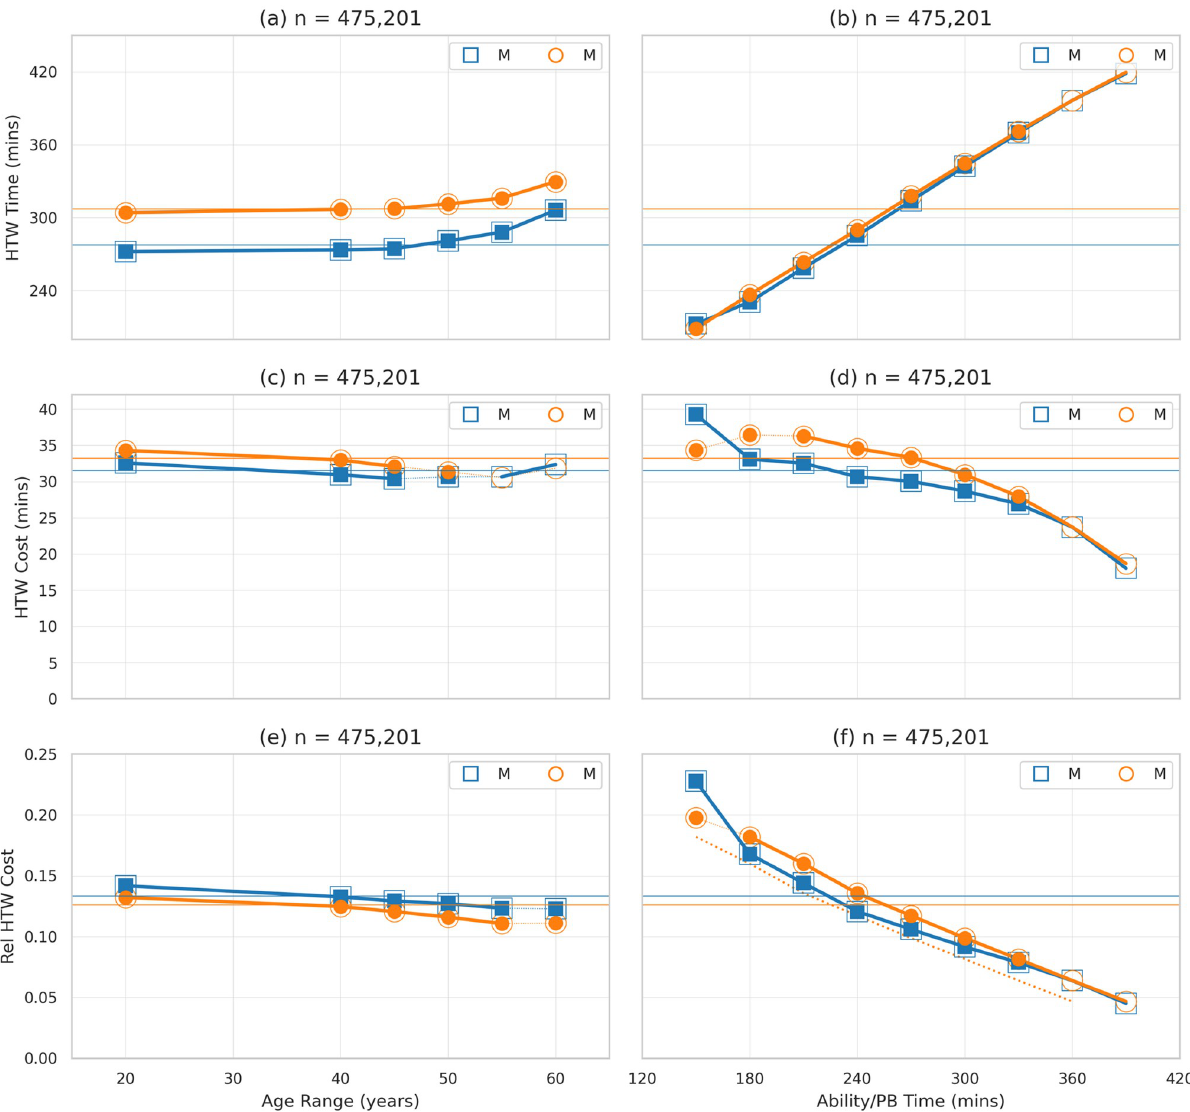
Fig 6. The finish-time and cost associated with hitting the wall for male and female runners by age range and ability. HTW Time refers to the finish-time in minutes when a runner hits the wall. HTW Cost refers to the difference between a runner’s HTW Time and their estimated PB time. Rel HTW Cost refers to a runner’s HTW Cost as a fraction of their PB